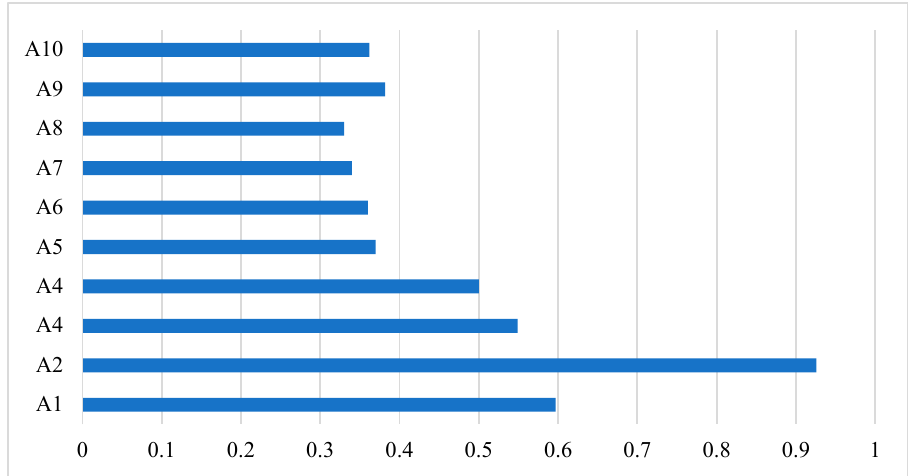
Figure 5. Performance evaluation of authentication alternatives